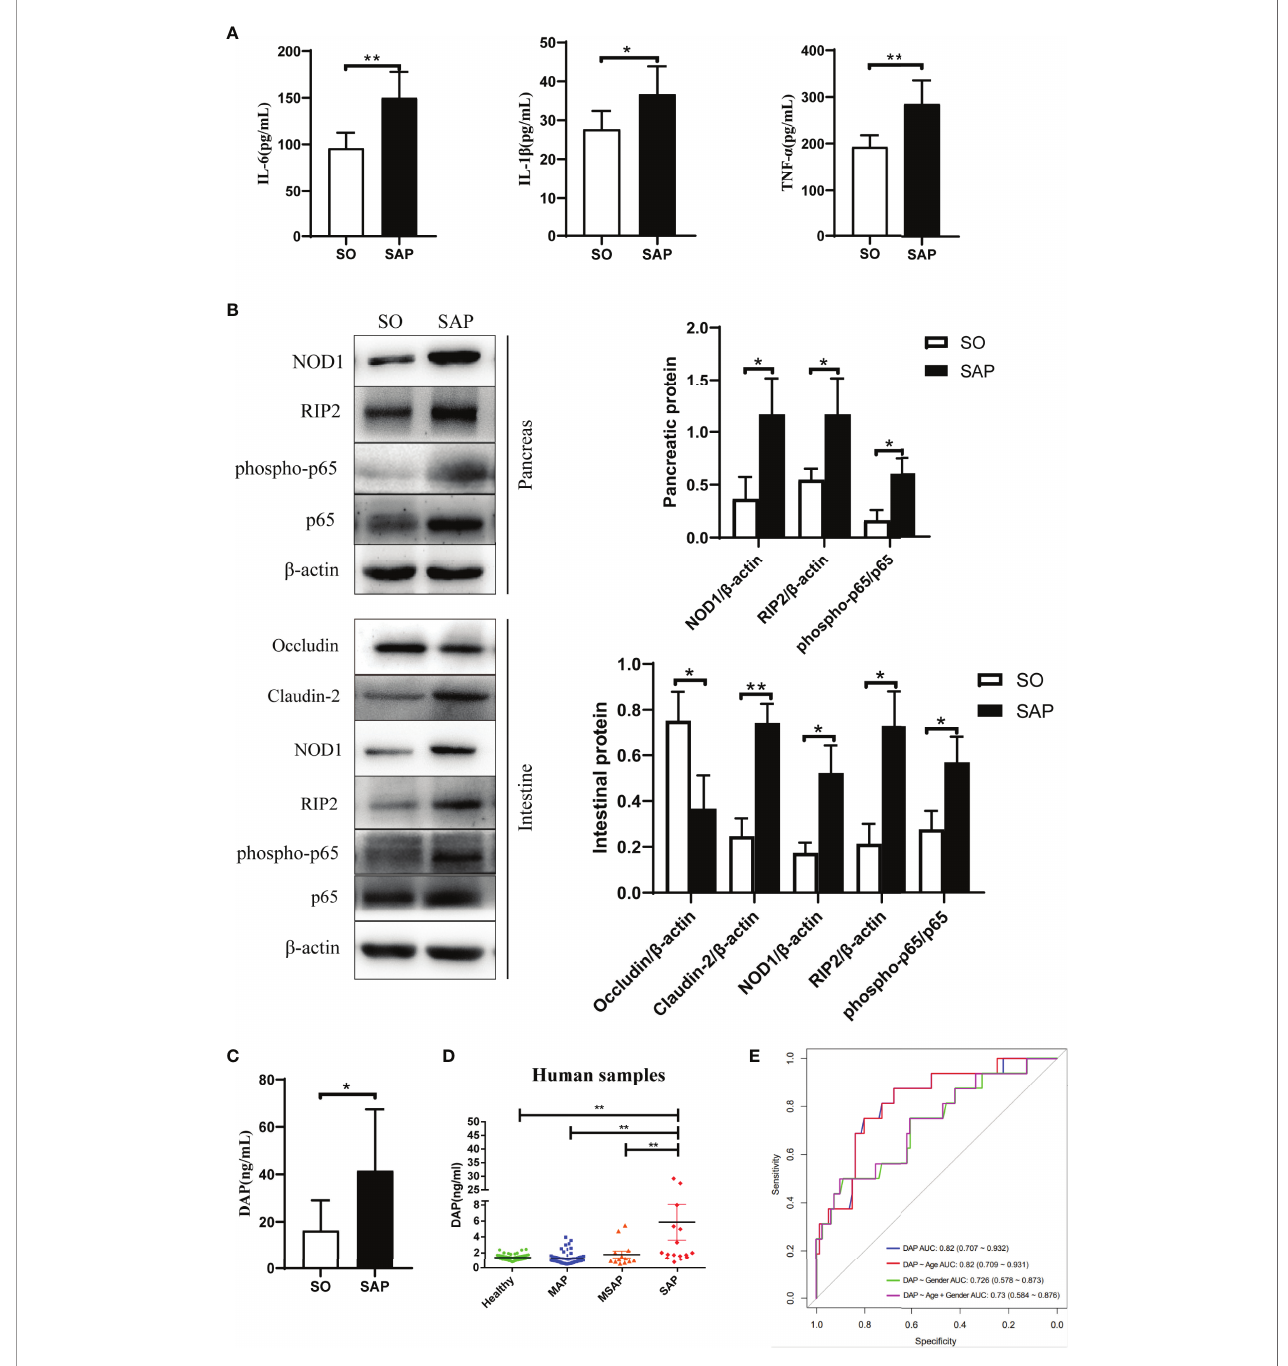
FIGURE 2 | DAP activated the NOD1/RIP2 in fl ammatory signaling pathway and participated in the systemic in fl ammatory response in SAP rats, and an elevated serum DAP level was detected in SAP patients. (A) The levels of IL-6, IL-1 b and TNF- a in the serum of SO and SAP rats; (B) Protein expression of pancreatic and intestinal NOD1 signaling pathway, and intestinal barriers proteins Occludin and Claudin-2 by western blotting; (C) Determination of serum DAP levels in SO and SAP rats by UHPLC-TOMS; (D) Determination of serum DAP levels in patients with AP of different severities; (E) Receiver operator characteristic (ROC) analysis for distinguishing between MAP/MSAP and SAP by the serum DAP level. MAP, mild acute pancreatitis; MSAP, moderately severe acute pancreatitis; SAP, severe acute pancreatitis. Student ’ s t-test for A-C (n = 6 in each group of Panel A ; n = 3 in each group of Panel B ; for Panel C , n = 8 in SO group and n = 7 in SAP). ANOVA test for Panel D and ROC analysis for Panel E (n = 56 in healthy group, n = 68 in MAP group, n = 13 in MSAP group, n = 16 in SAP group); * p < 0.5, ** p <